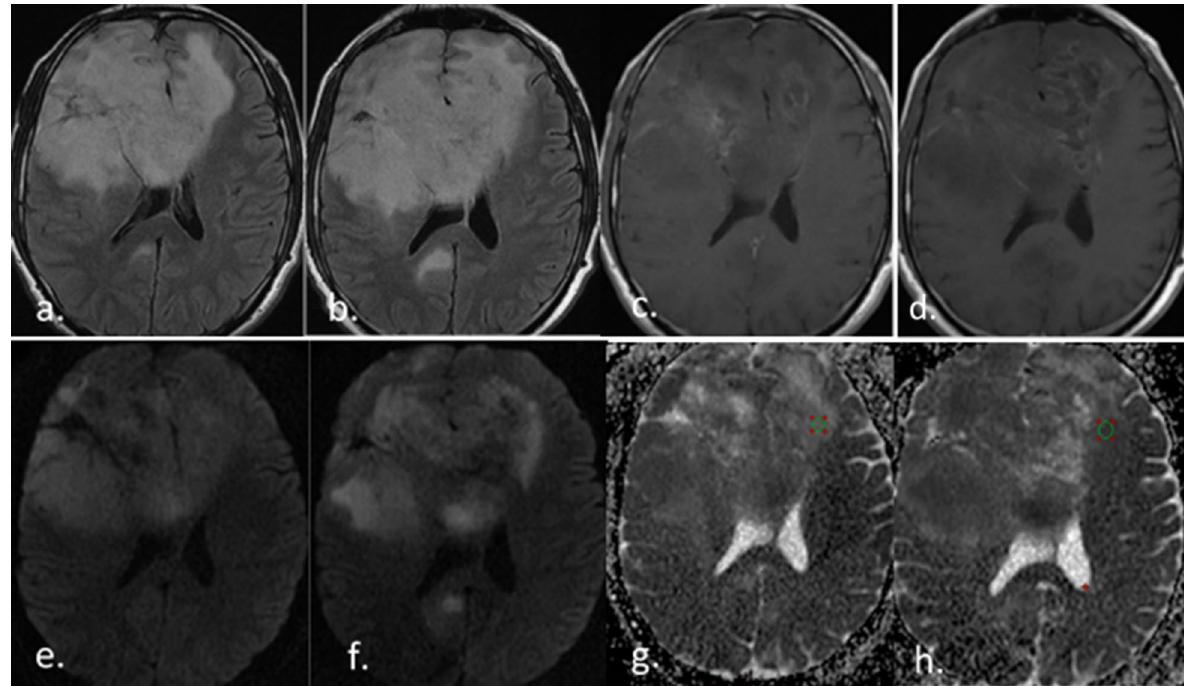
Fig. 4 A 49-year-old clinically-stable male patient with bi-frontal grade IV glioblastoma multiforme finished chemoradiotherapy 7 months ago. a and b Axial FLAIR images of the first and second studies, respectively show an increase of the FLAIR component by less than 25%. No changes in the surrounding mass effect. c and d Axial post-contrast T1 WIs of the first and second studies, respectively show an increase in the enhancing component by less than 25% in the follow-up study. e and f Axial DWI and g and h Axial ADC maps show a decrease of ADCmean in the enhancing resection cavity margin (1.3 10 − 3 mm 2 /s) and (0.99 10 − 3 mm 2 /s) in the first and second studies, respectively. BT-RADS category 3b was given with × × an intermediate probability of tumor recurrence. Decrease ADCmean favor the possibility of tumor recurrence. Tumor progression was proved